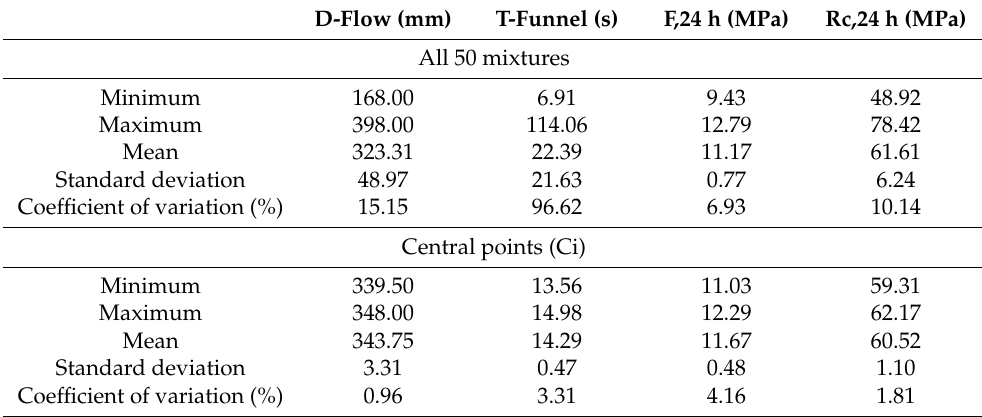
Table 4. The main statistics for all CCD points and central